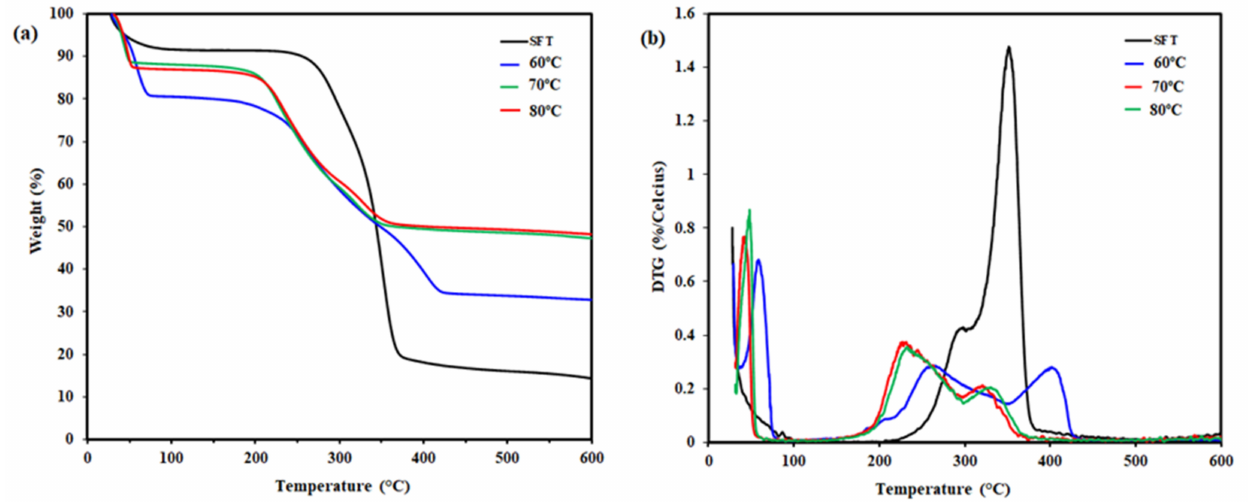
Figure 11. TGA ( a ) and DTG ( b ) thermograms of STFs and CNCs under different oxidation tempera- tures with a 1.5 M APS concentration for 16